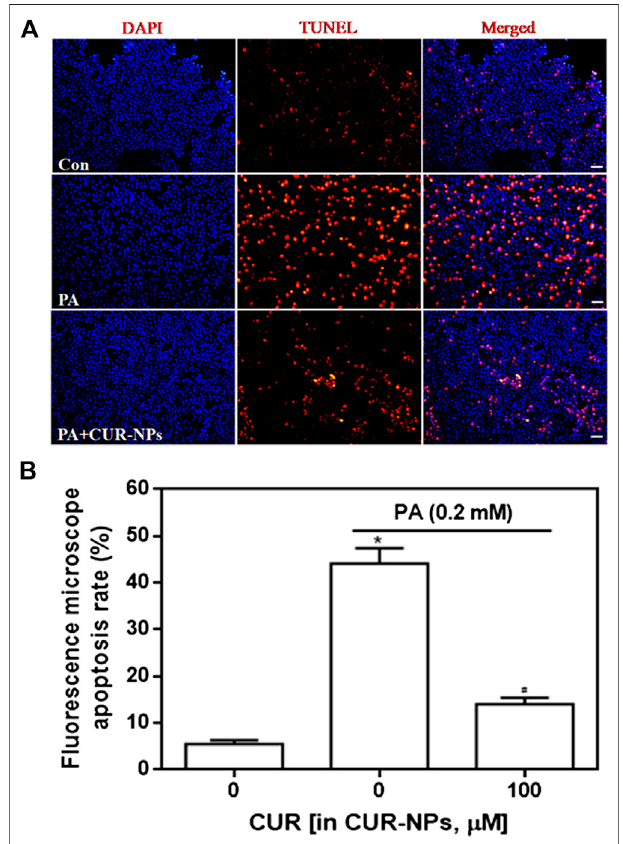
FIGURE 4 | Effect of CUR-NPs on PA-induced cardiomyocyte apoptosis (A) TUNEL fl uorescence staining image data of cardiomyocyte apoptosis (bar is 20 μ m) (B) Quantitative analysis for TUNEL staining by fl uorescence microscopy. * p < 0.05 vs control group; # p < 0.05 vs PA group.